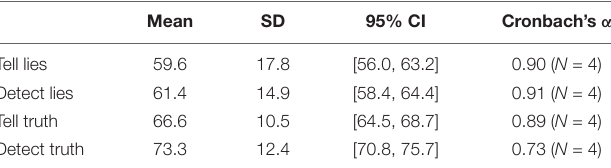
TABLE 9 | Statistics of the